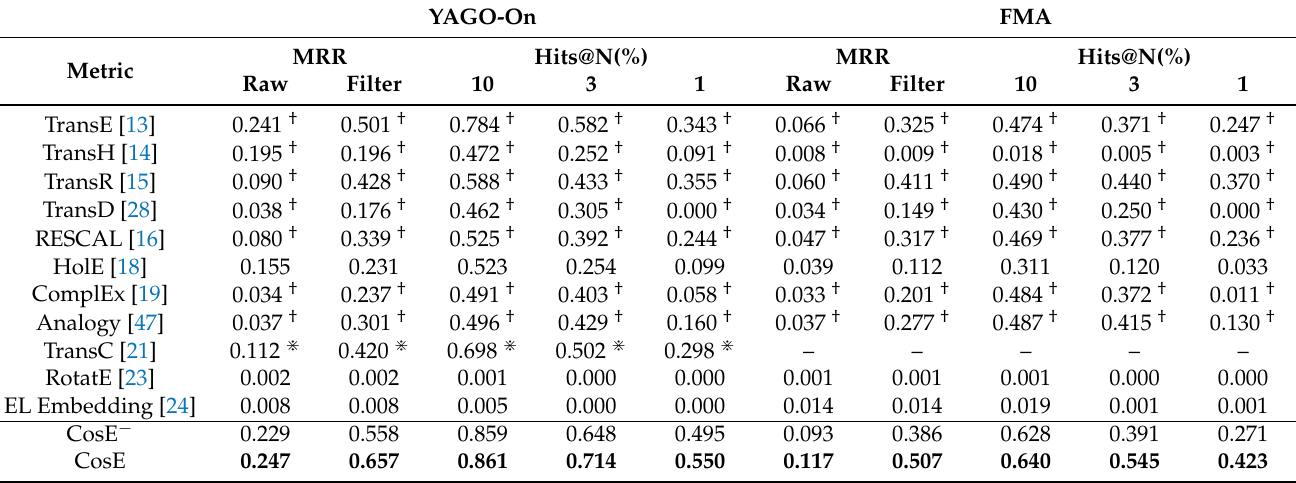
Table 2. The results of YAGO-On and FMA on link prediction. YAGO-On FMA